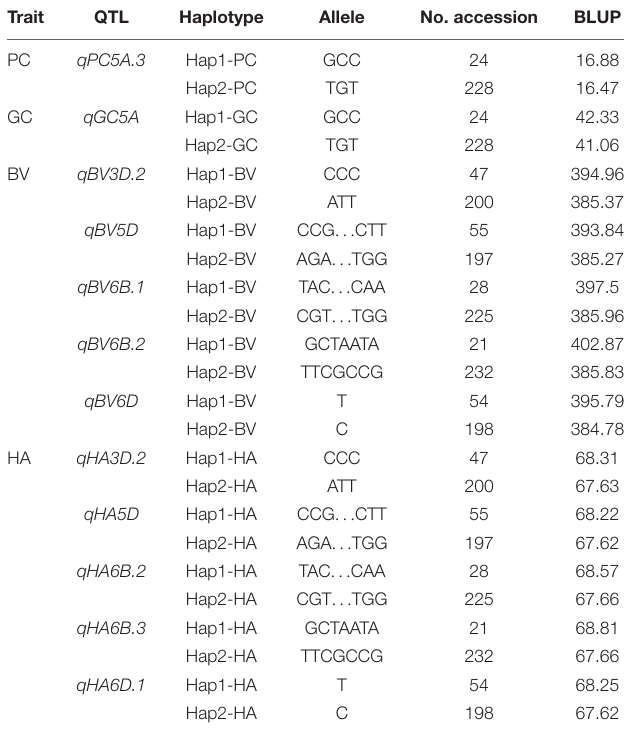
TABLE 4 | Analysis of the haplotype effects of the stable QTL on chromosomes 3D, 5A, 5D, 6B, and 6D.